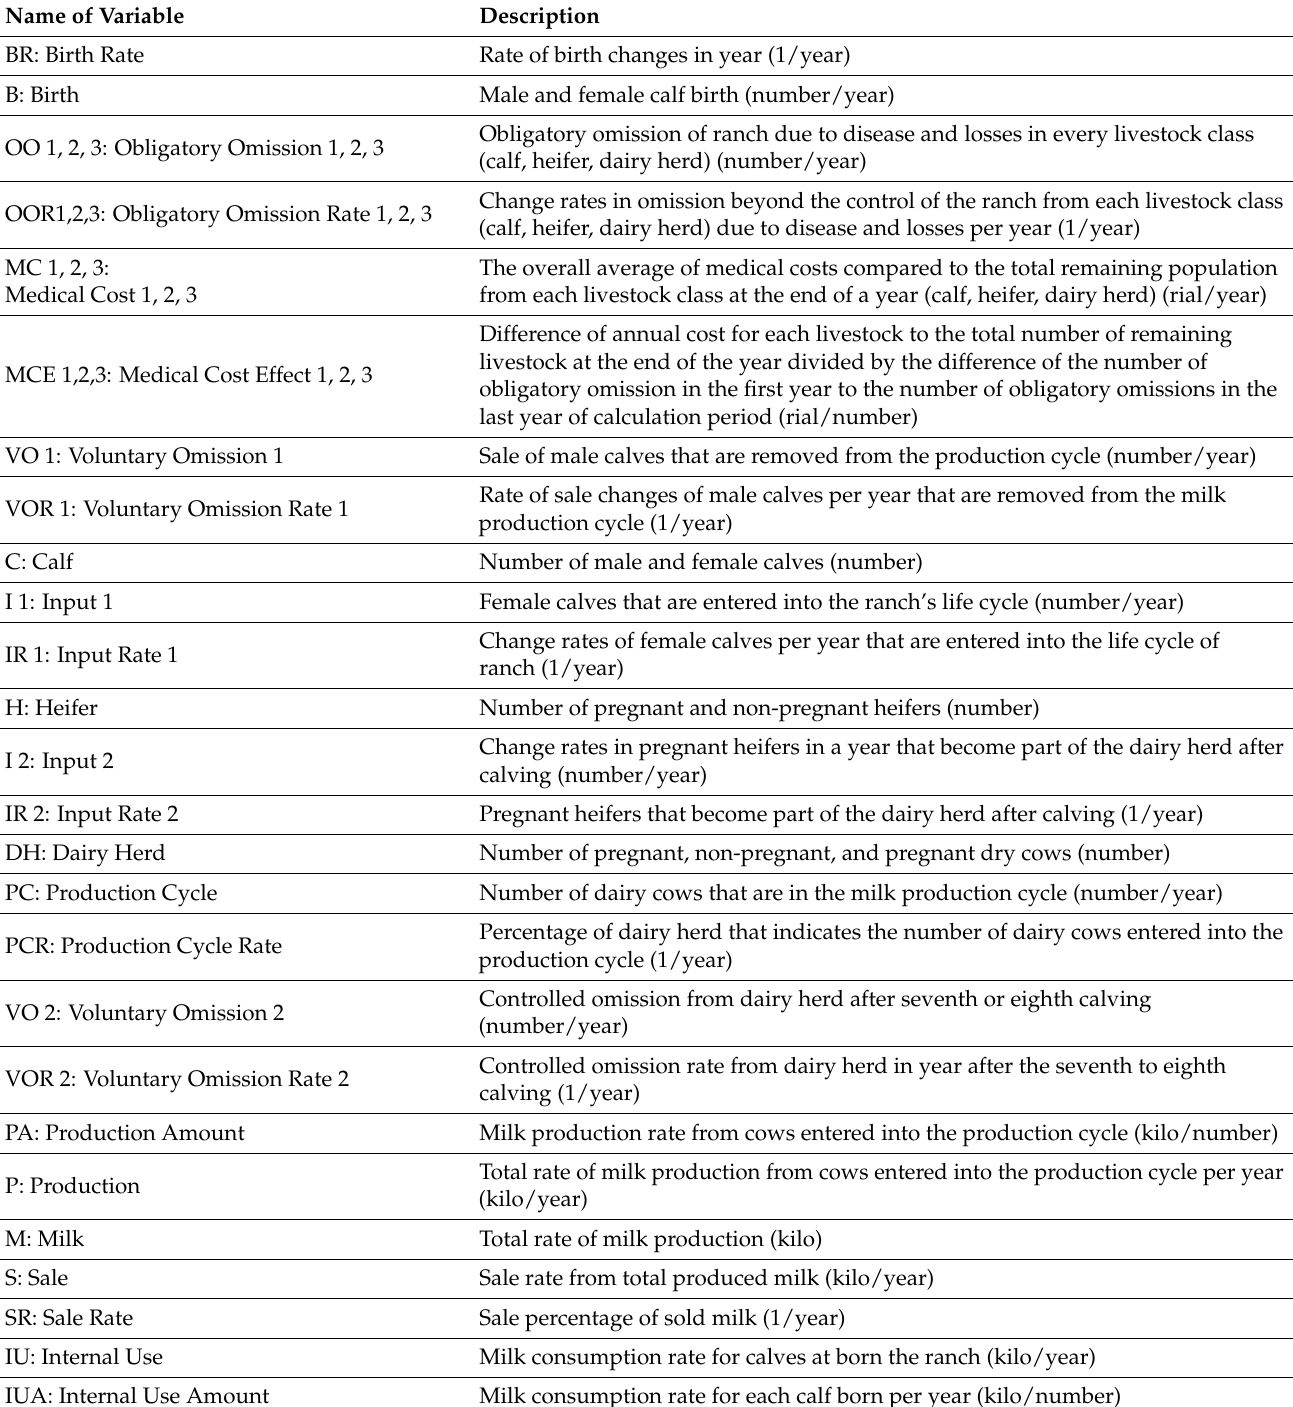
Table 1. Variables of the stock–flow diagram of the Fereidan Ahrar